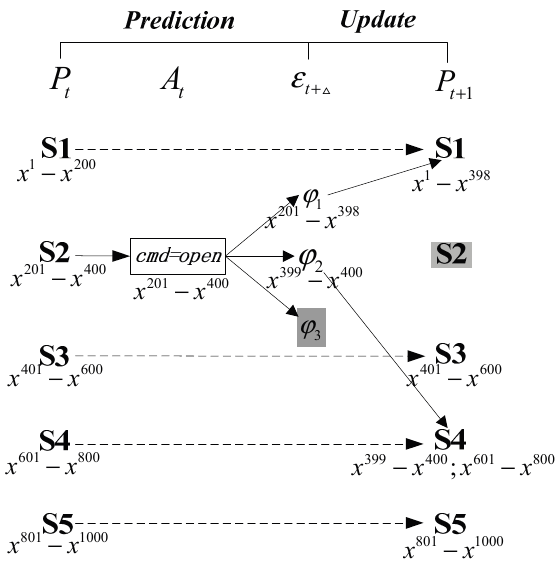
Figure 2. Relay depicted by